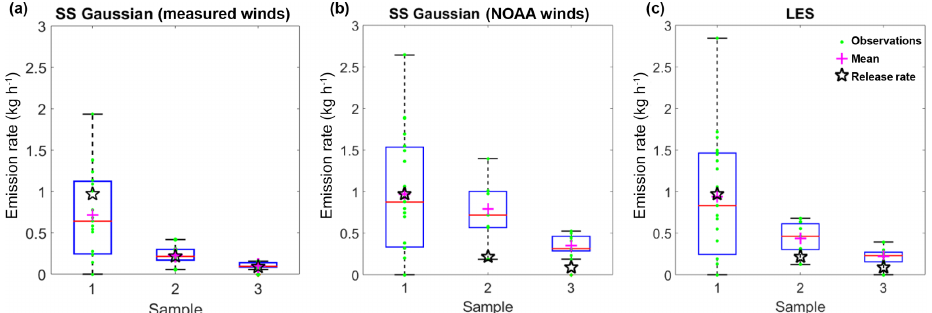
Figure 9. Results from three controlled release experiments for (a) the Gaussian approach using tower-measured winds, (b) the Gaussian approach using NOAA winds and (c) from the LES. Box and whiskers plots show the 50th percentile (red), 25th and 75th percentile (blue), and minimum and maximum values (black). The mean is shown in magenta, green dots represent individual measurements and the black star is the actual release rate. NOAA winds diverged from the measured winds significantly in releases 2 and